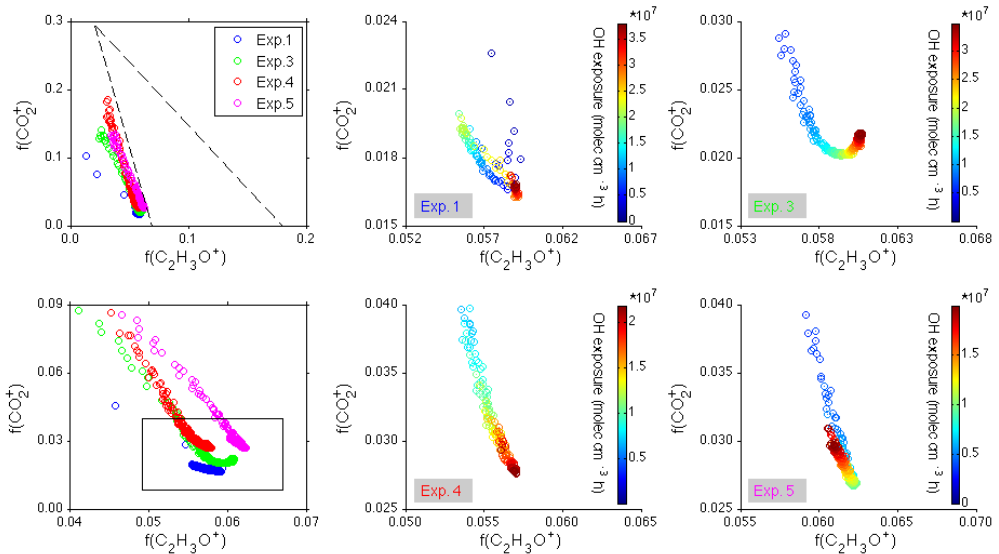
Fig. 8. SOA evolution as a function of OH exposure vs. O 3 exposure from dodecane photochemistry under high-NO x conditions in the f 44 vs. f 43 space. The top-left graph shows the combination of all the data, and the bottom-left graph shows an expanded version. The other graphs show the specific behavior of each experiment: Exp. 1 corresponds to a regime in which OH oxidation of dihydrofuran is dominant. Exp. 3, 4, and 5 correspond to a regime in which ozonolysis of dihydrofuran is dominant, at 10, 20, and 50% RH, respectively.